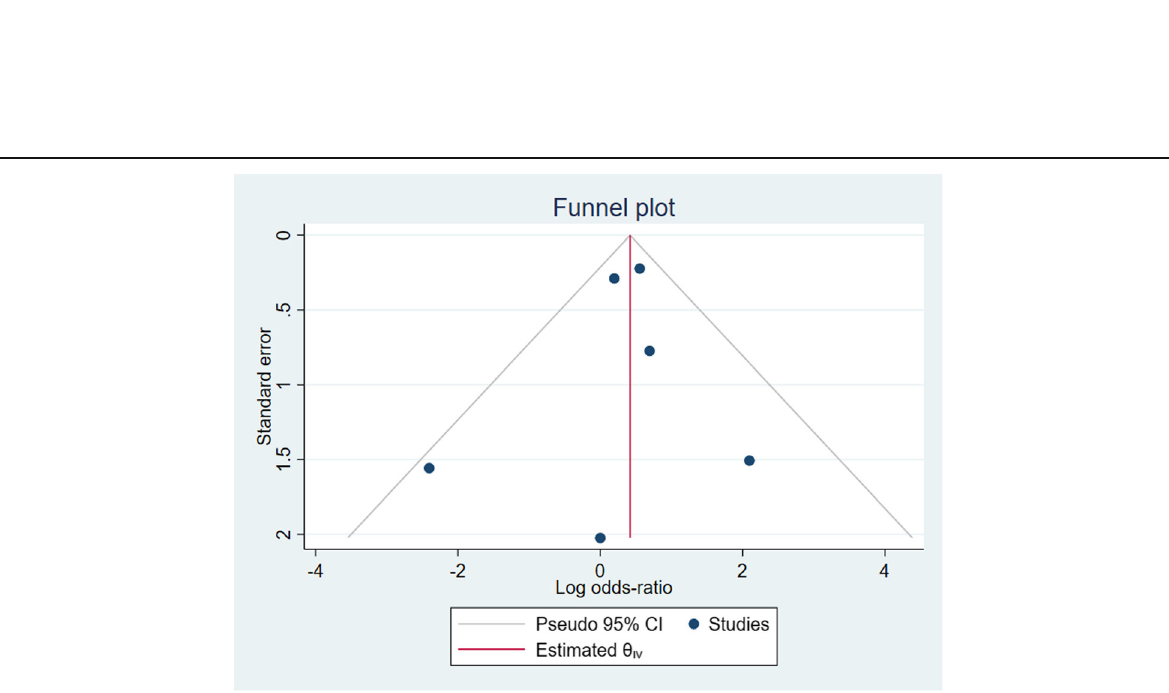
Fig. 12 Funnel plots showing no publication bias for the revision rate